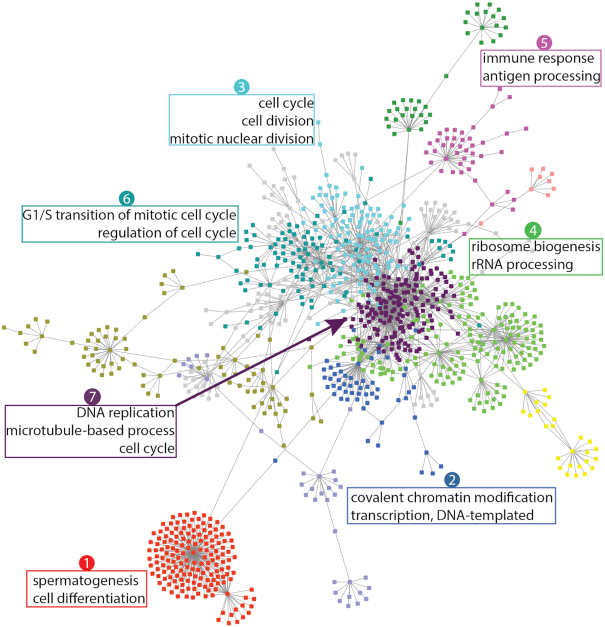
Functional clusters in the MM progression gene network. The gene clusters are shown in different colors and visualized using a mammalian gene-gene interaction network. The shared biological processes of selected clusters are labeled.